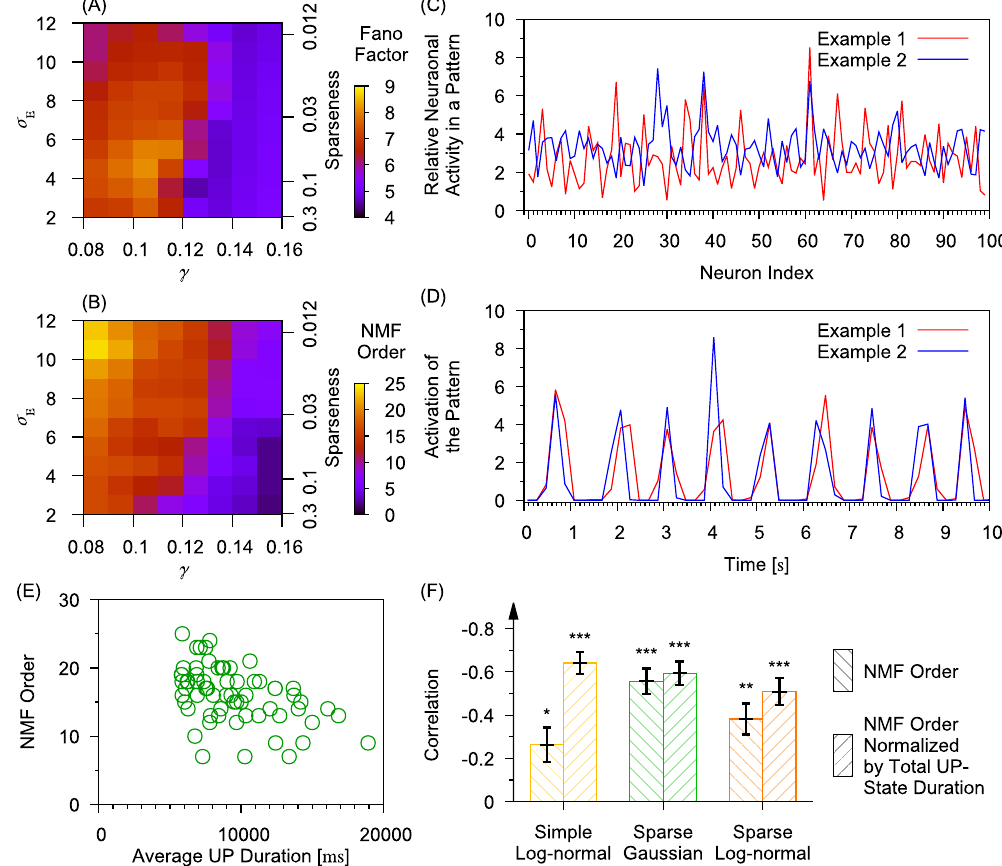
Figure 7. Cell-assembly structure of UP states in sparse-lognomal networks. ( A ) Fano factors measured at different parameter values for sparse-log-normal connection weight distributions. Parameter: c . ( B ) Optimal NMF order detected by AICc within the same parameter range used in ( A ). ( C ) Two examples of the ensemble activity patterns during transient UP states detected by NMF are displayed. The firing rates are only shown for 100 neurons selected randomly from the network. ( D) Occurrence of the two patterns extracted by NMF is shown during repeated UP states. Parameters for ( C and D ): N E = 1000, γ I = γ E = 0.1 and σ E = 5.0. ( E ) The optimal number of patterns is plotted against the average transient-UP-state duration. ( F ) Correlations were calculated between the original and normalized NMF orders and logarithms of the average transient-UP- state duration. Asterisks: p -values for the significant levels of the negative correlation coefficients. * p < 0.05. ** p < 0.01. *** p <